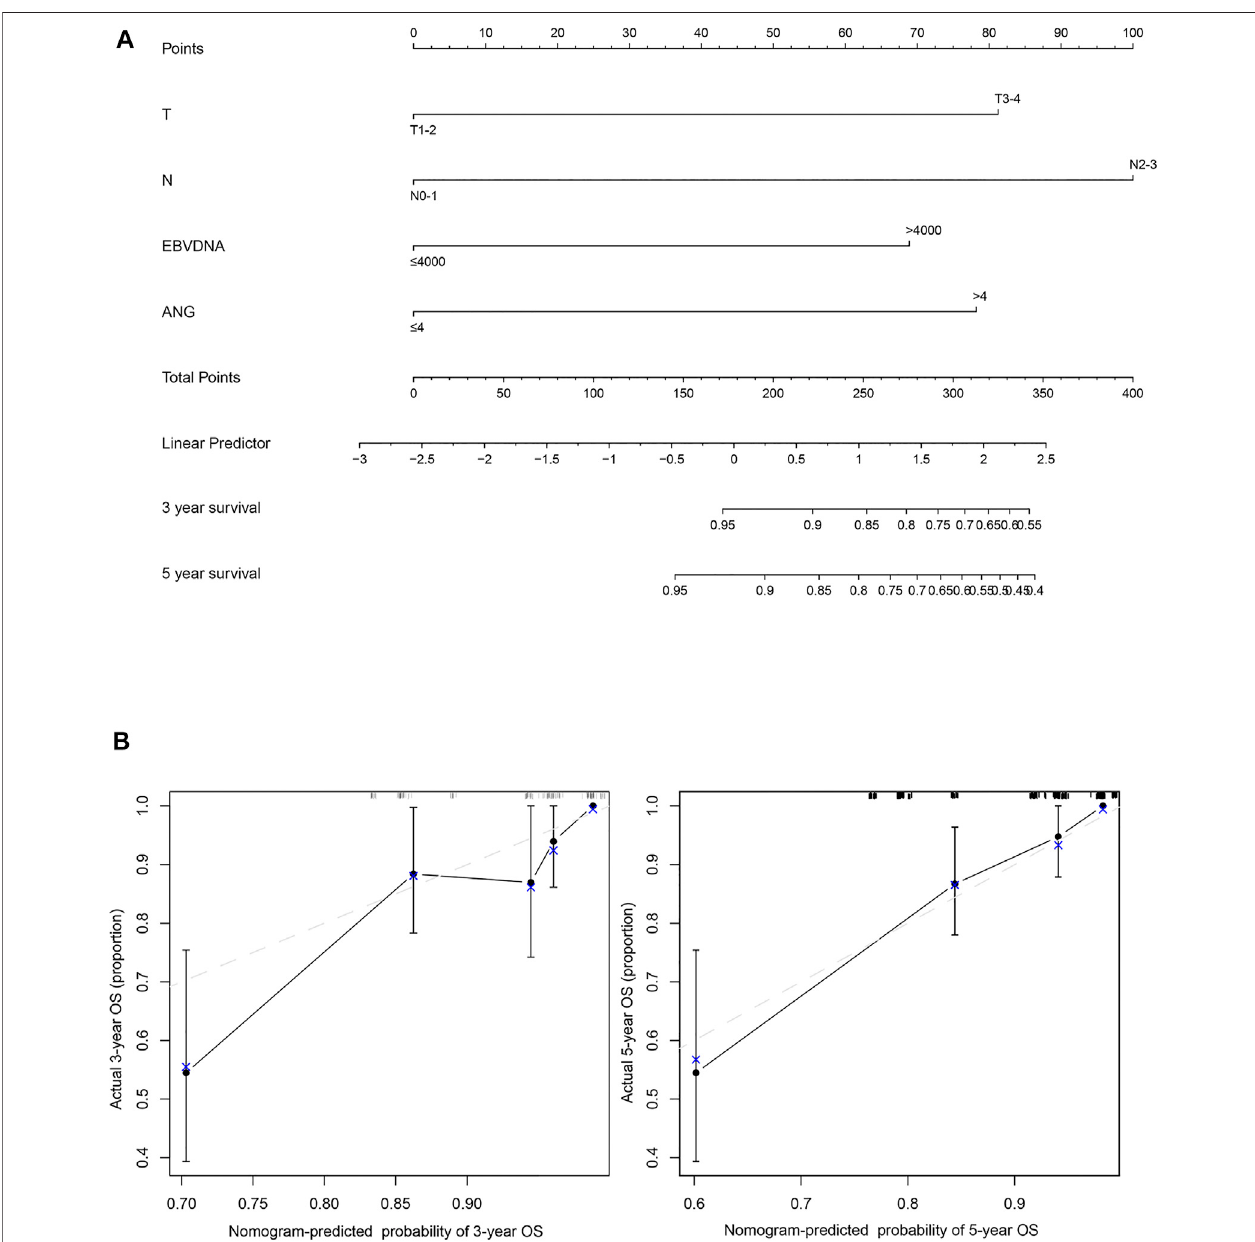
FIGURE 4 | The nomogram and model calibration curve. (A) Nomogram including T stage, N stage, EBV DNA, and ANG expression levels in patients with nasopharyngeal carcinoma. (B) Model calibration curve showing the predicted and actual probabilities of ANG expression.